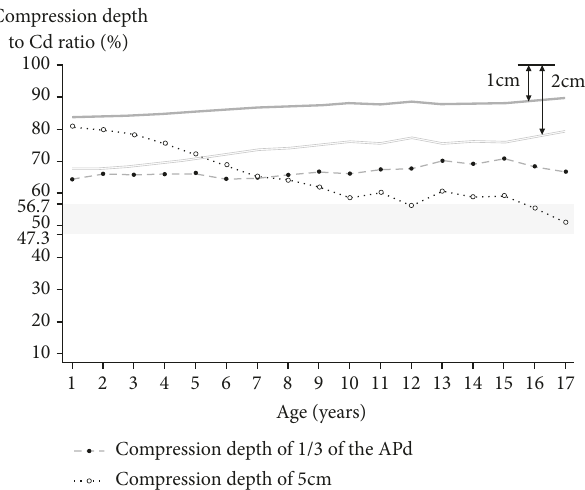
Figure 3: Compression depth to Cd ratios whenchestcompressions were performed at 1/3 of the APd or 5 cm by age group among patients aged 1–18 years. The white and black circles represent the mean ratios. The gray area represents the range of compression depthtoCdratiowhenchestcompressionswereperformedbetween 5 cm (47.3%) and 6 cm (56.7%) in adults. The gray bold line and the gray double line are the boundaries that indicate the residual depth of 1 cm and 2 cm, respectively. APd: anteroposterior diameter; Cd: compressible